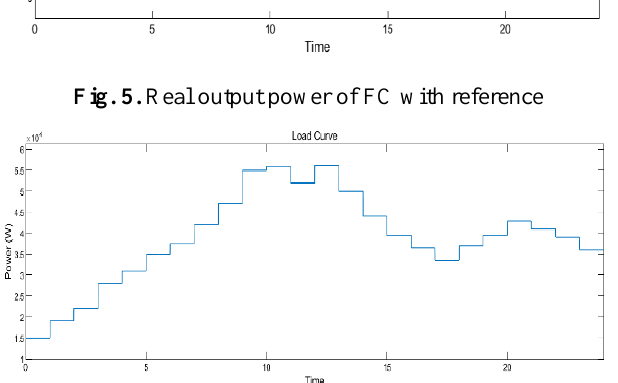
Fig.9. Voltage of load